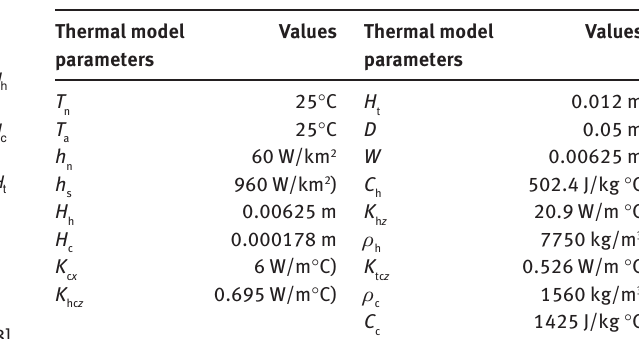
Figure 2 Three-component geometry and boundary conditions